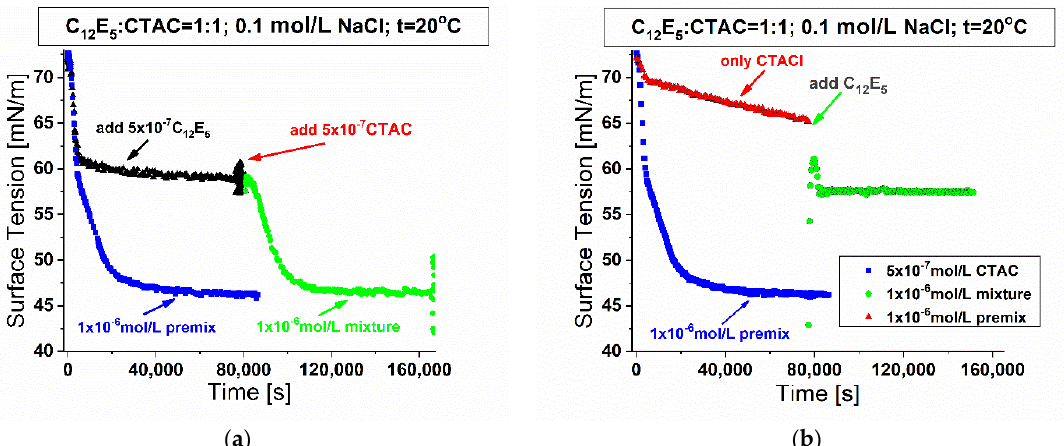
Figure 9. Dynamic surface tension isotherms of “premixed” and “supplement method” surfactant solutions. Final solutions are 1:1 mixtures with total surfactant concertation 1.0 × 10 −6 mol/L. ( a ) CTAC solution is added to the previously obtained C 12 E 5 system; ( b ) C 12 E 5 solution is added to the previously obtained CTAC system.